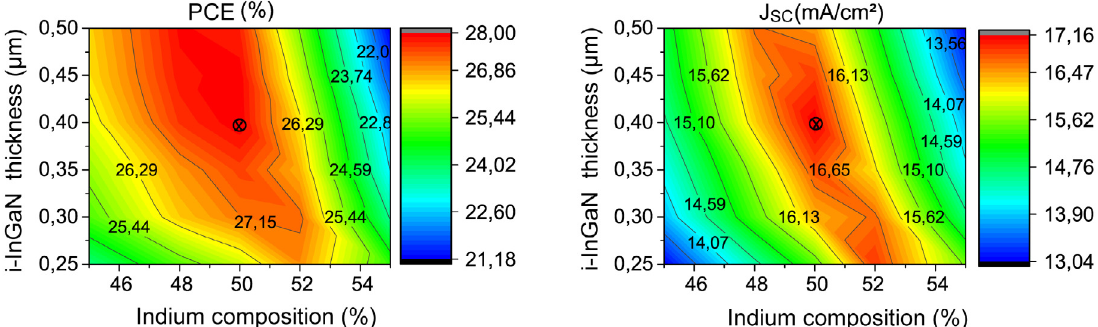
Fig. 2. PCE (left) and J sc (right) of InGaN/Si 2-terminal tandem cell as a function of indium composition and i-InGaN thickness of InGaN-based top cell.